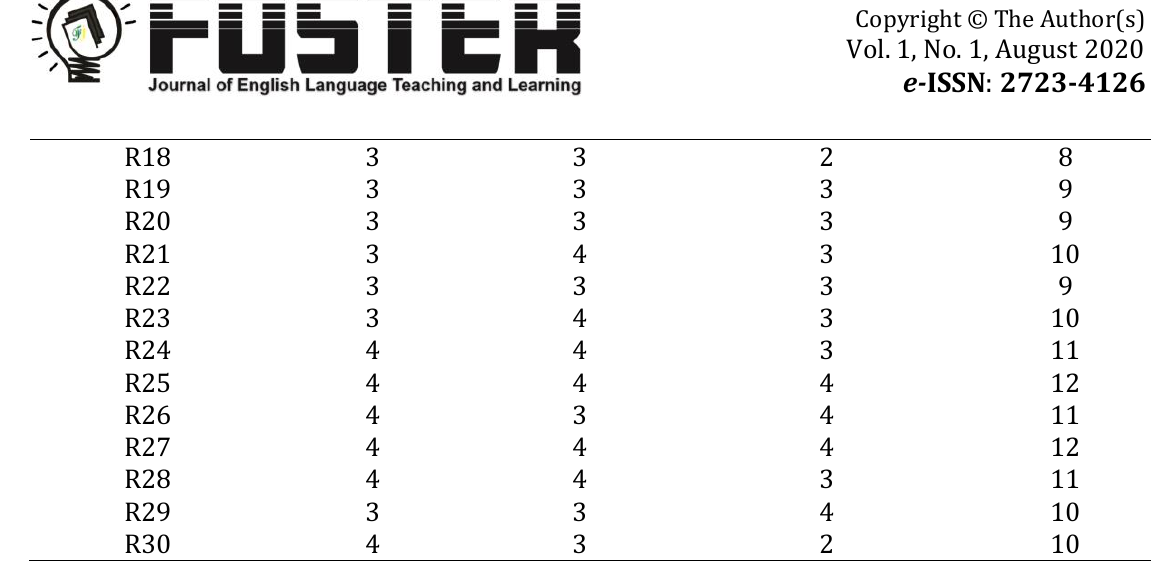
Table 4.10 The Percentage Rate Score students of Accuracy in Posttest Result in Class Experimental Classification